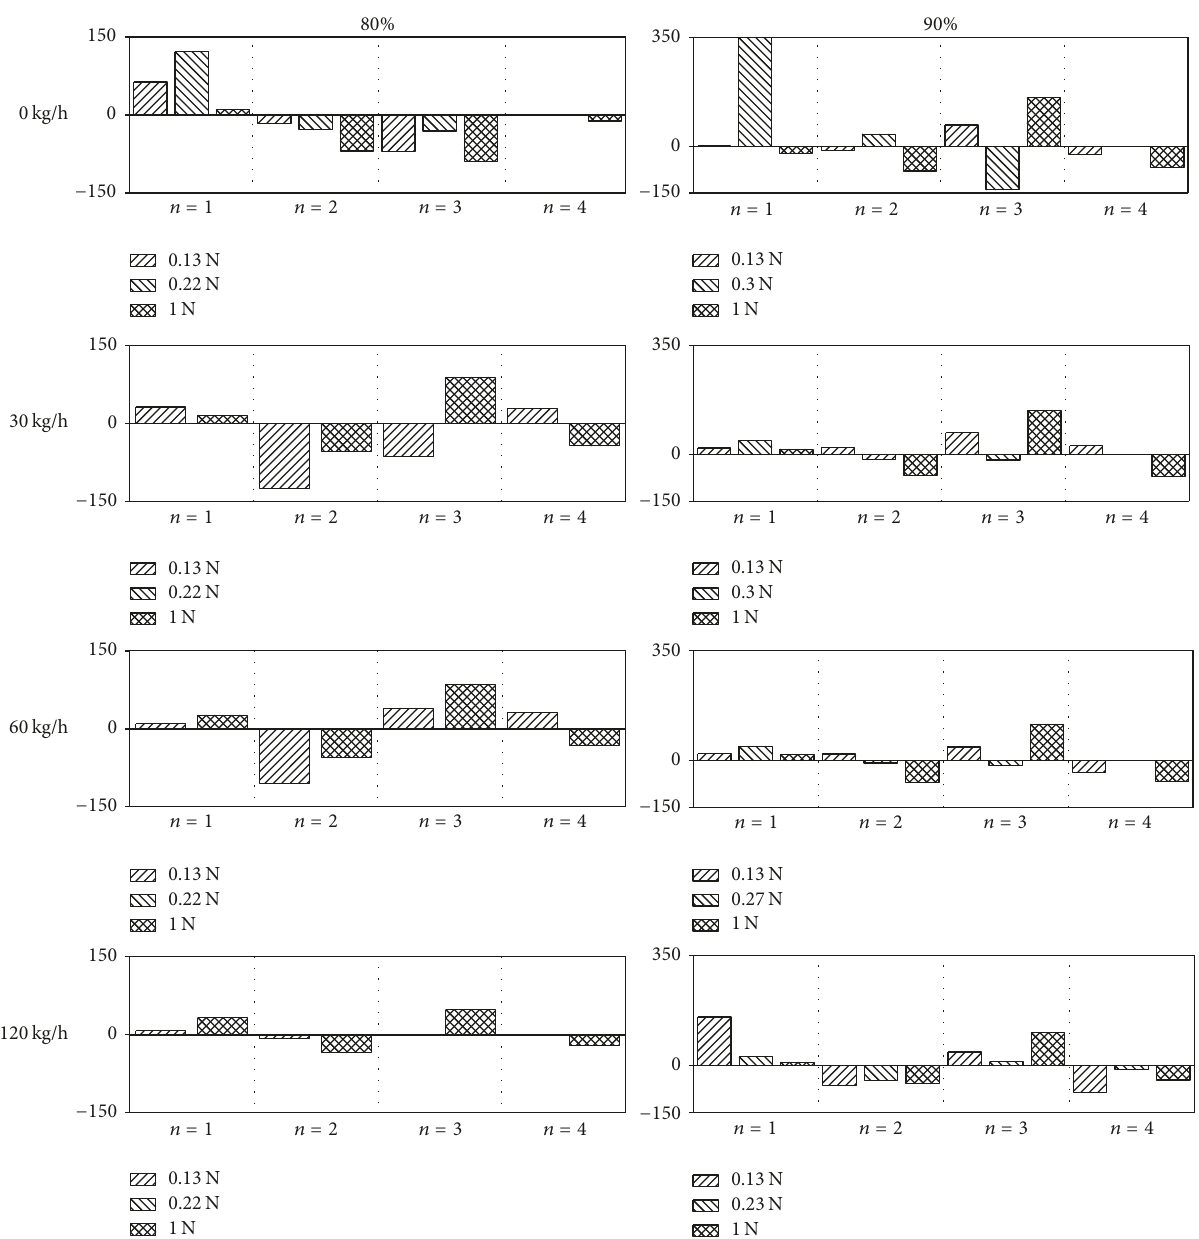
pressure ratio and efficiency were observed in steam injected technology